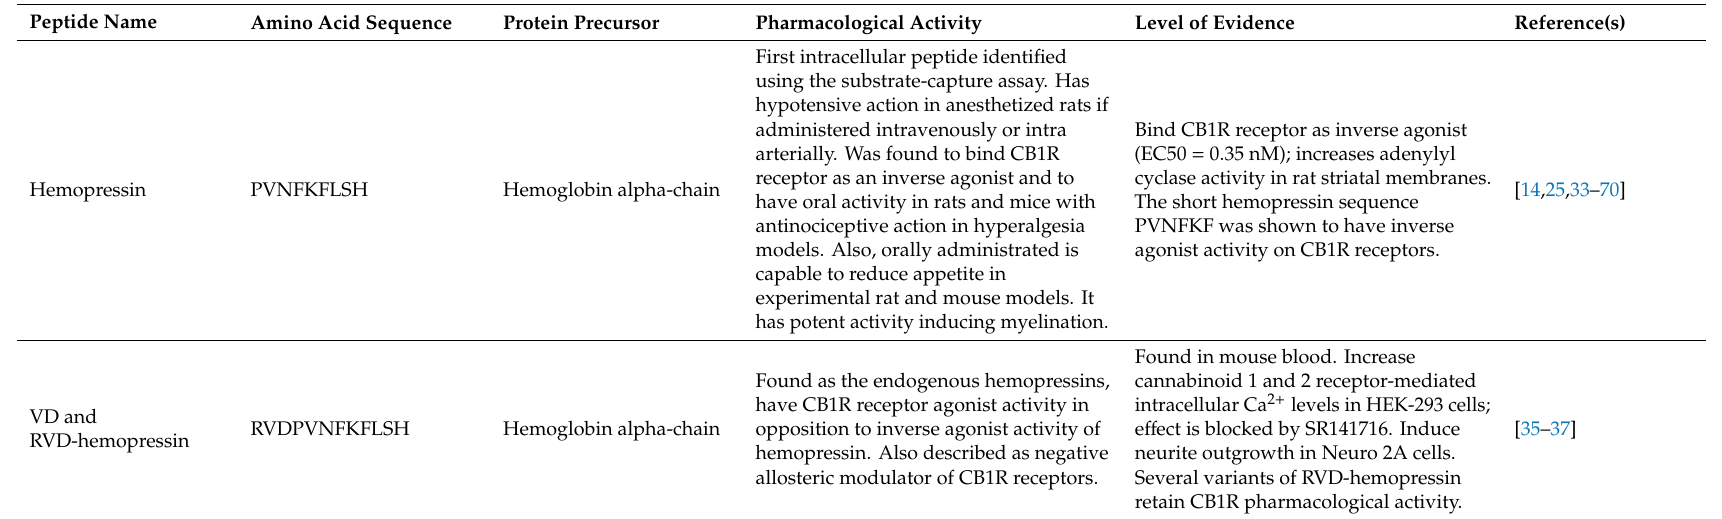
Table 1. Intracellular peptides with characterized pharmacological